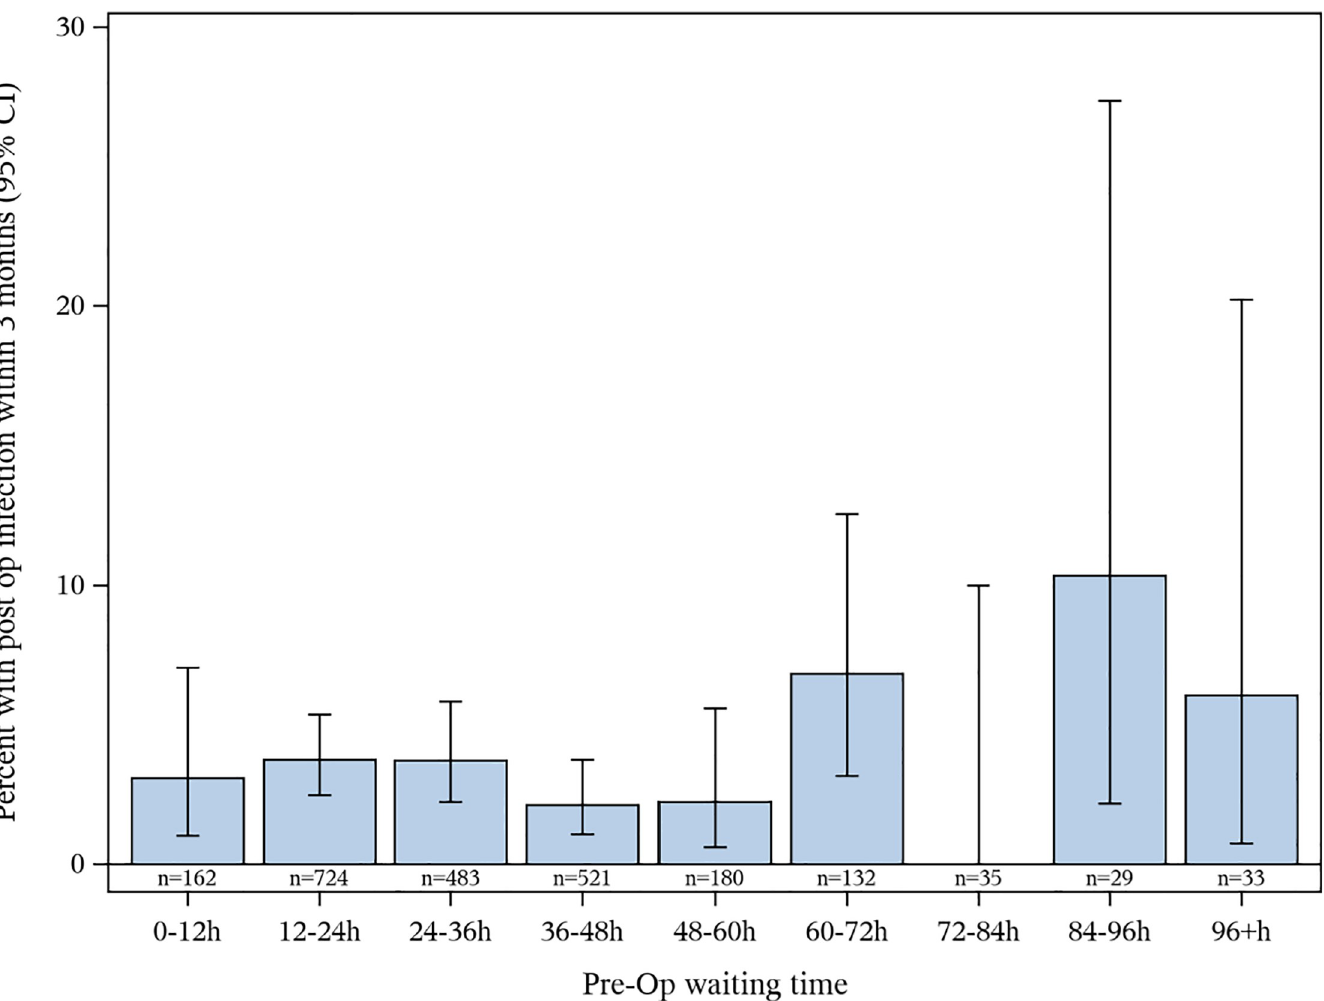
Fig 2. The rates of PJI within 3 months following hip hemiarthroplasty based on the time from patient presentation in the emergency department with an acute hip fracture to the time of surgery.